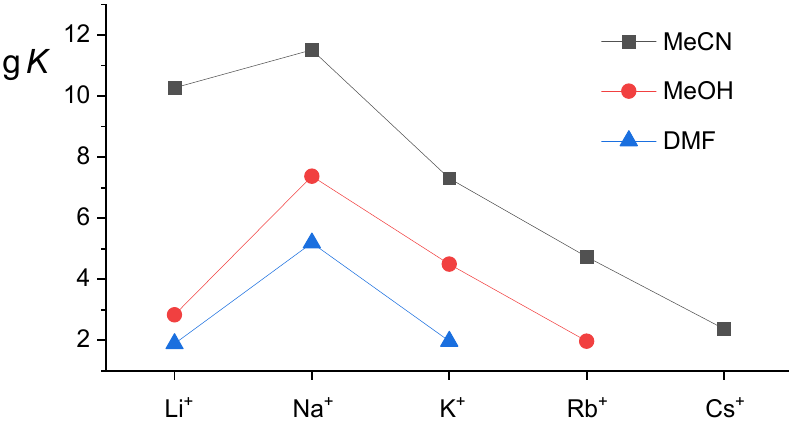
Figure 3. The stability constants of alkali metal cation complexes with calixarene L in explored media.